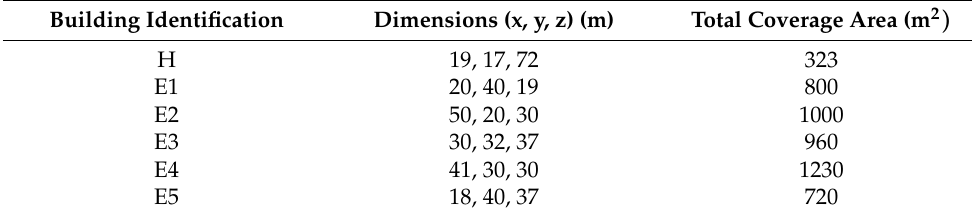
Table 2. Dimensions of the buildings of the study